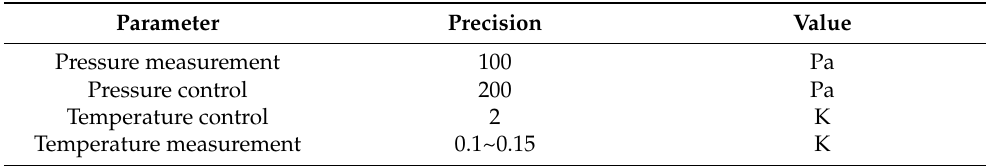
Table 5. Index parameters of the absorption cell.